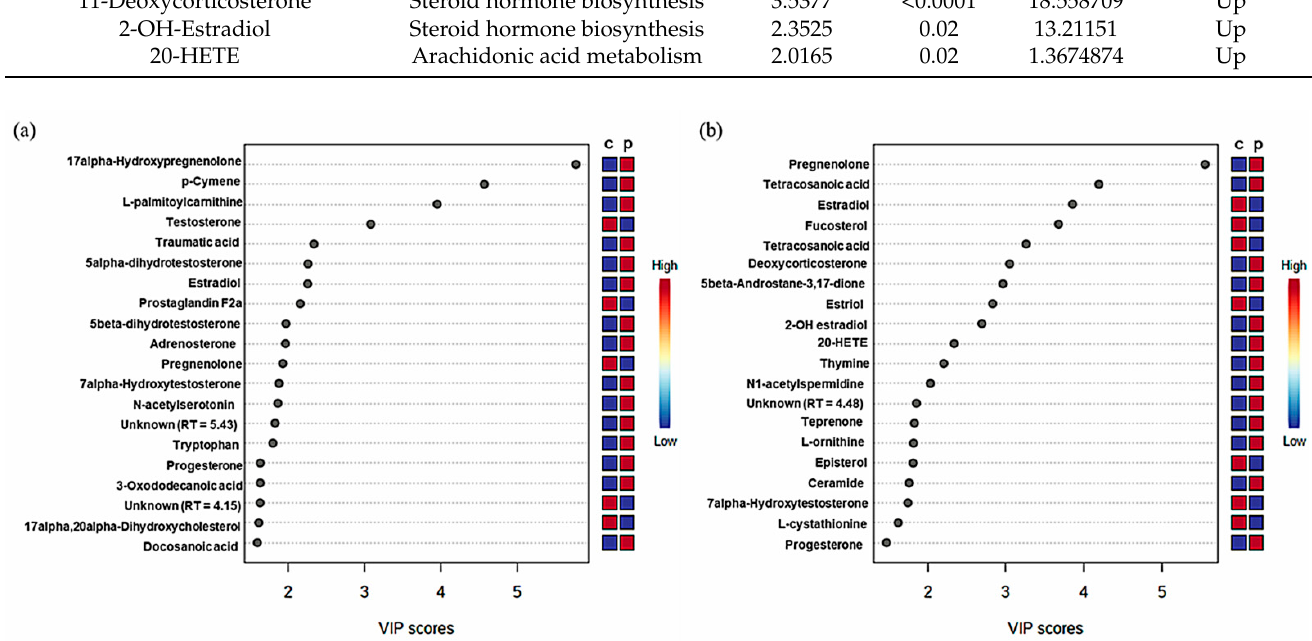
Figure 3. The top 20 scores of variable importance in projection (VIP) values. On the left part of the graph, significant difference of metabolites are indicated. The main graph represents the VIP scores. On the right part of the graph, dark red indicates high abundance and dark blue indicates low abundance, respectively. ( a ) Male groups and ( b ) female groups; c, normal controls; p, pattern baldness patients.